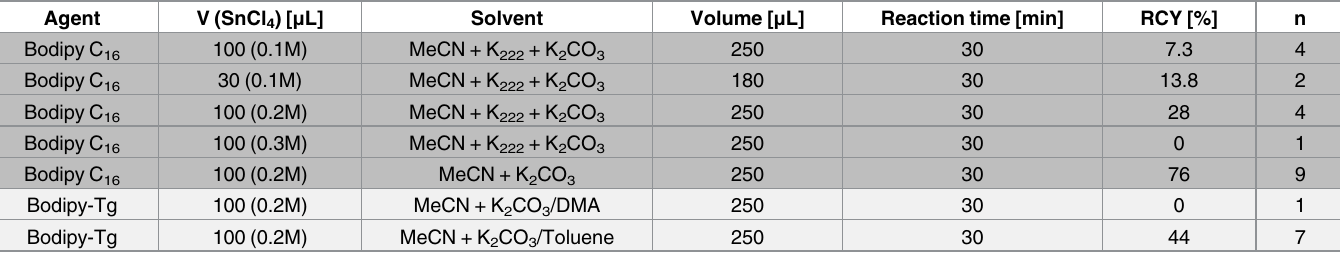
Table 2. Radiolabeling of BDP-FA 3 and BDP-TG 4. Different conditionstested for both compounds.Radiochemical yields calculatedafter purification. Agent V (SnCl 4 ) [ μ